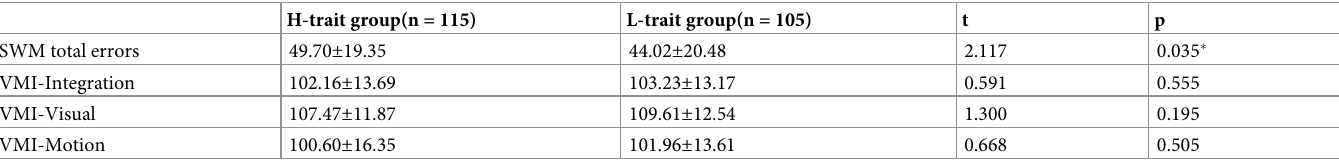
Table 4. Tasks performance differences between different trait group on Spatial Working Memory (SWM) and Berry-VMI. H-trait group(n = 115) L-trait group(n =